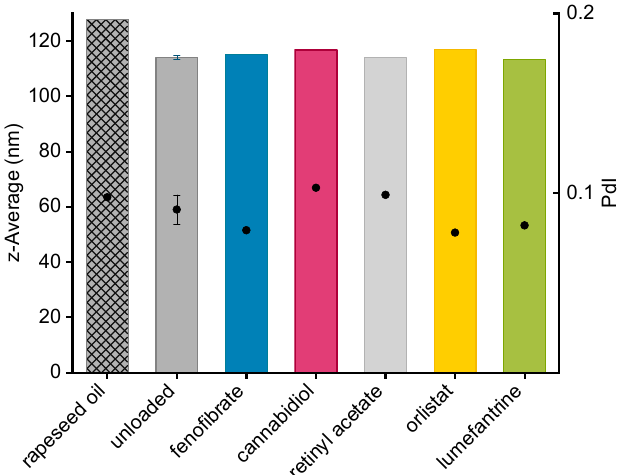
Figure 1. Droplet size (z-Average, represented as bars) and polydispersity index (PdI) values (PdI, represented as dots) of different batches of unloaded trimyristin emulsions (n = 6 ± standard deviation), drug-loaded donor emulsions (also with trimyristin matrix) as well as the rapeseed oil emulsion (patterned bar) as determined via photon correlation spectroscopy.